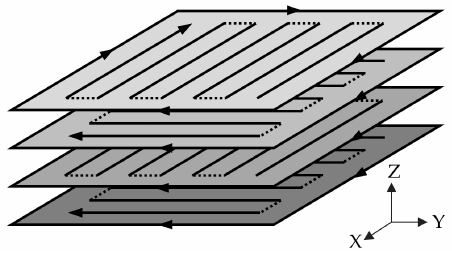
Figure 3. L-DED deposition strategy. Table 2. Chemical composition of the deposited layers.